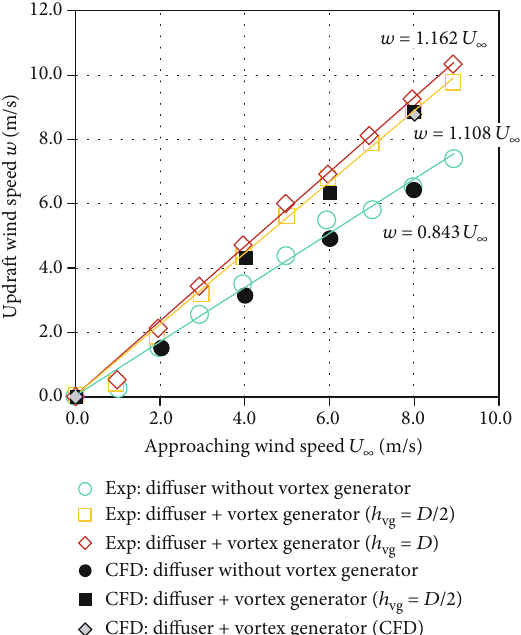
Figure 10: Updraft wind speeds in the case of the cylindrical tower. The solid symbols represent the numerical results. The open symbols represent the experimental results.